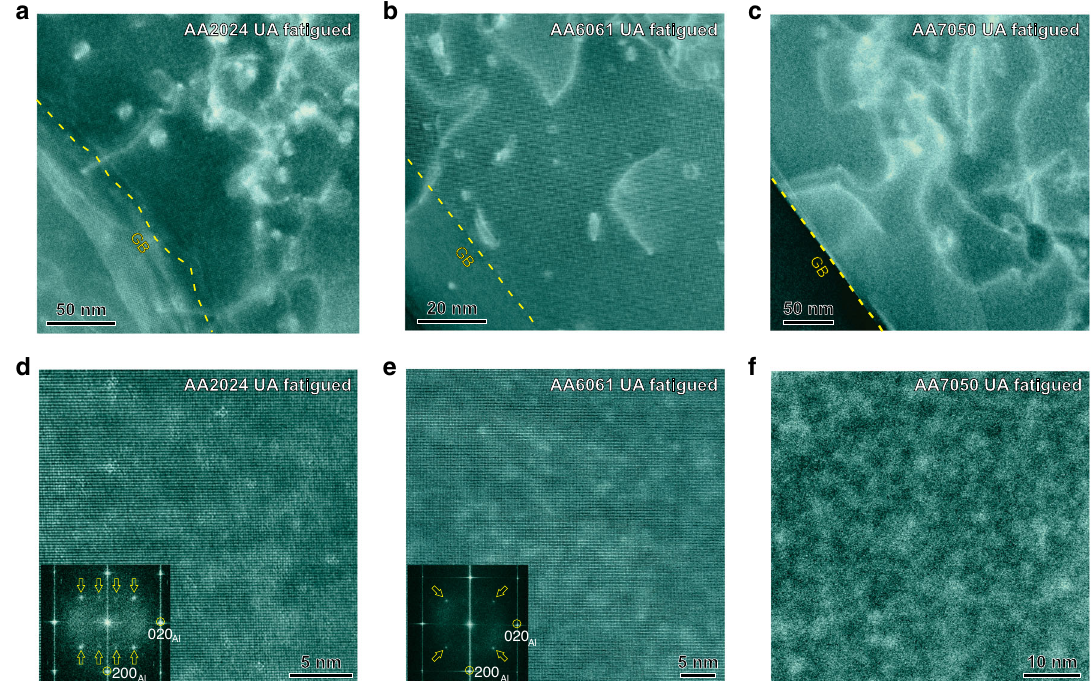
Fig. 4 LAADF-STEM images showing the microstructure of precipitate-free zones (PFZ ’ s) after HCF deformation. a – c PFZ ’ s of high cycled fatigue (HCF) treated under aged (UA) samples for AA2024 ( a ), AA6061 ( b ), and AA7050 ( c ). AA2024 was fatigued at 185 MPa for 3.5 × 10 6 cycles, AA6061 was fatigued at 120 MPa for 4 × 10 6 cycles, and AA7050 was fatigued at 175 MPa for 8 × 10 6 cycles. d – f High-magni fi cation LAADF-STEM images showing nanoprecipitates existing in PFZ ’ s pointed out in a – c . Corresponding fast Fourier transform (FFT) patterns inserted in d , e reveal diffraction from nanoprecipitates (pointed by yellow color hollow arrows). The electron beam direction was parallel to <100> Al in a , b , d , e and parallel to <110> Al in c , f